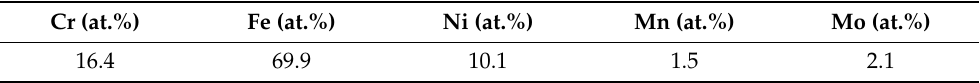
Table 1. Chemical composition of the AISI 316L substrate obtained by EDS. Cr (at.%) Fe (at.%) Ni (at.%) Mn (at.%) Mo